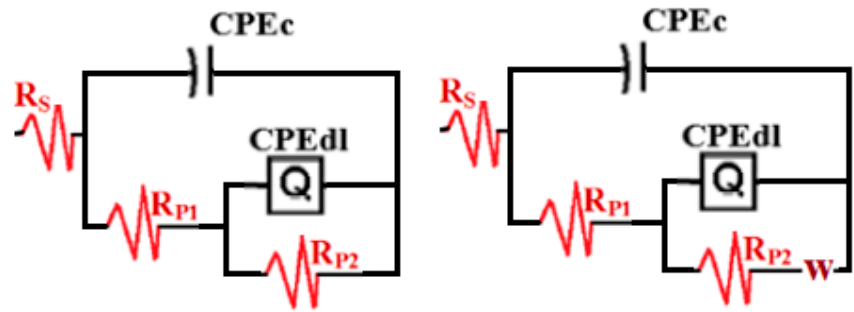
Figure 11. Equivalent electrical circuit models fitted to the obtained impedance.